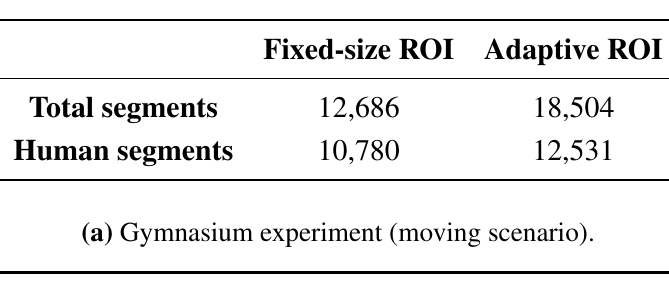
Table 4. Data sets used for fusion detection. Different ROI projection sizes lead to different data